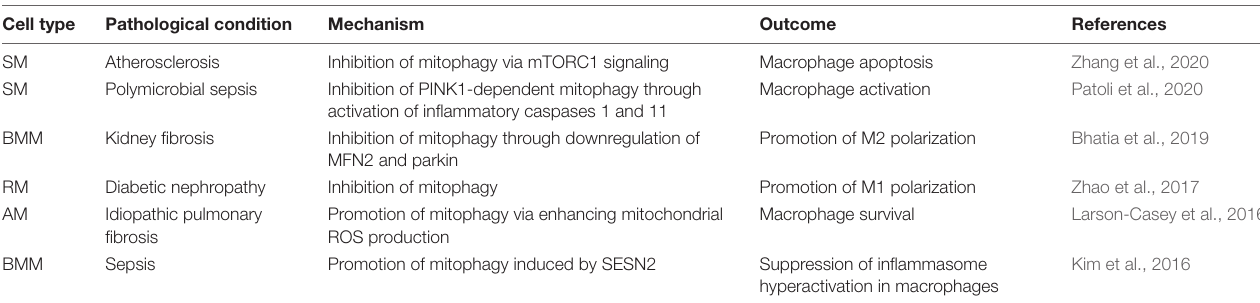
TABLE 3 | Mechanisms of mitophagy in